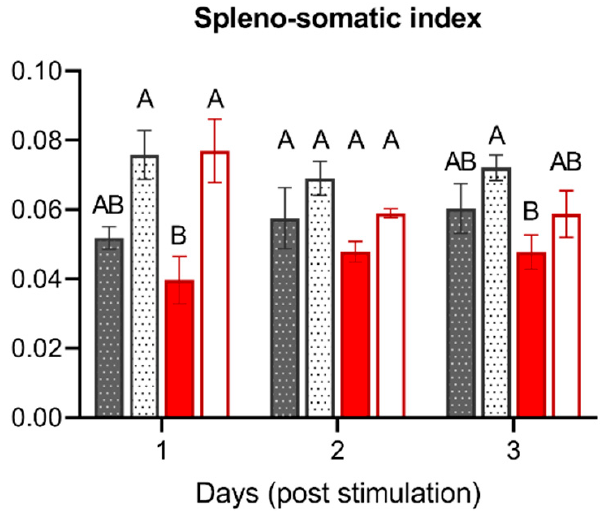
Figure 5. Spleno-somatic index of pikeperch during acute peritoneal inflammation. Spleno-so- matic indices of pikeperch after one, two and three days post intraperitoneal stimulation with in- activated Aeromonas hydrophila cells. The graph shows differences between normoxic control groups, either unstimulated (dark grey/patterned) or stimulated (bright grey/patterned), and low DO groups, either unstimulated (dark red) or stimulated (bright red). Columns represent mean of four individual samples (+SEM). Statistical significance per each day was determined using the one-way ANOVA followed by Tukey´s multiple comparison test ( p = 0.05); different letters (A, B) represent significant changes between different control and low DO groups.